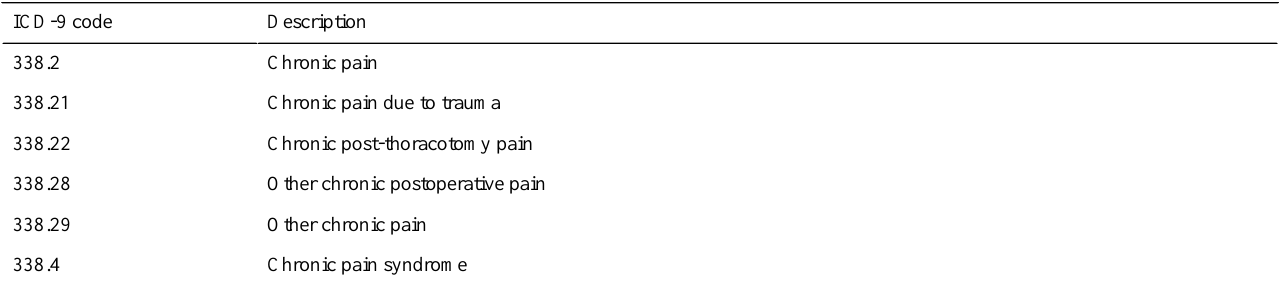
Table 1. International Classification of Diseases, Ninth Revision (ICD-9) codes determined by Tian et al [7] as highly likely to represent chronic